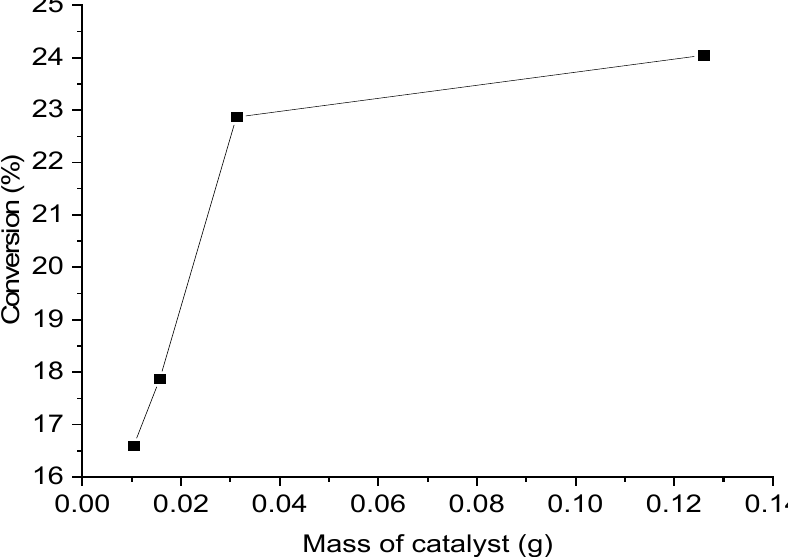
Figure 9. Effect of catalyst mass on conversion, in substrate:metal molar ratios of 500, 2000, 4000, and 6000. Reaction conditions: 25 °C, 0.5 M FA, 700 rpm, and 120 min reaction time.